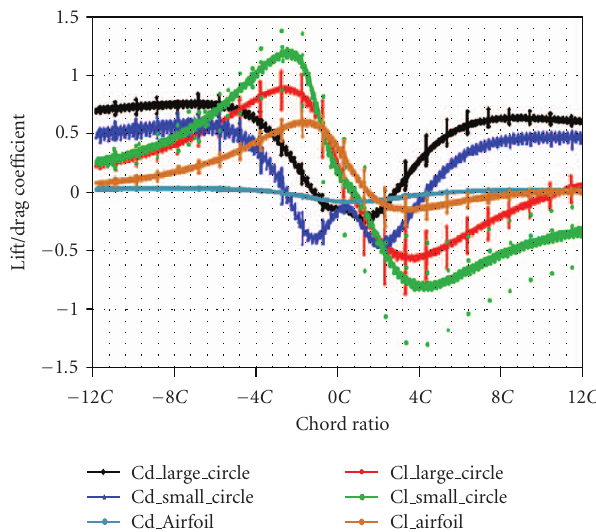
Figure 10: Lift and drag Coe ffi cients of the